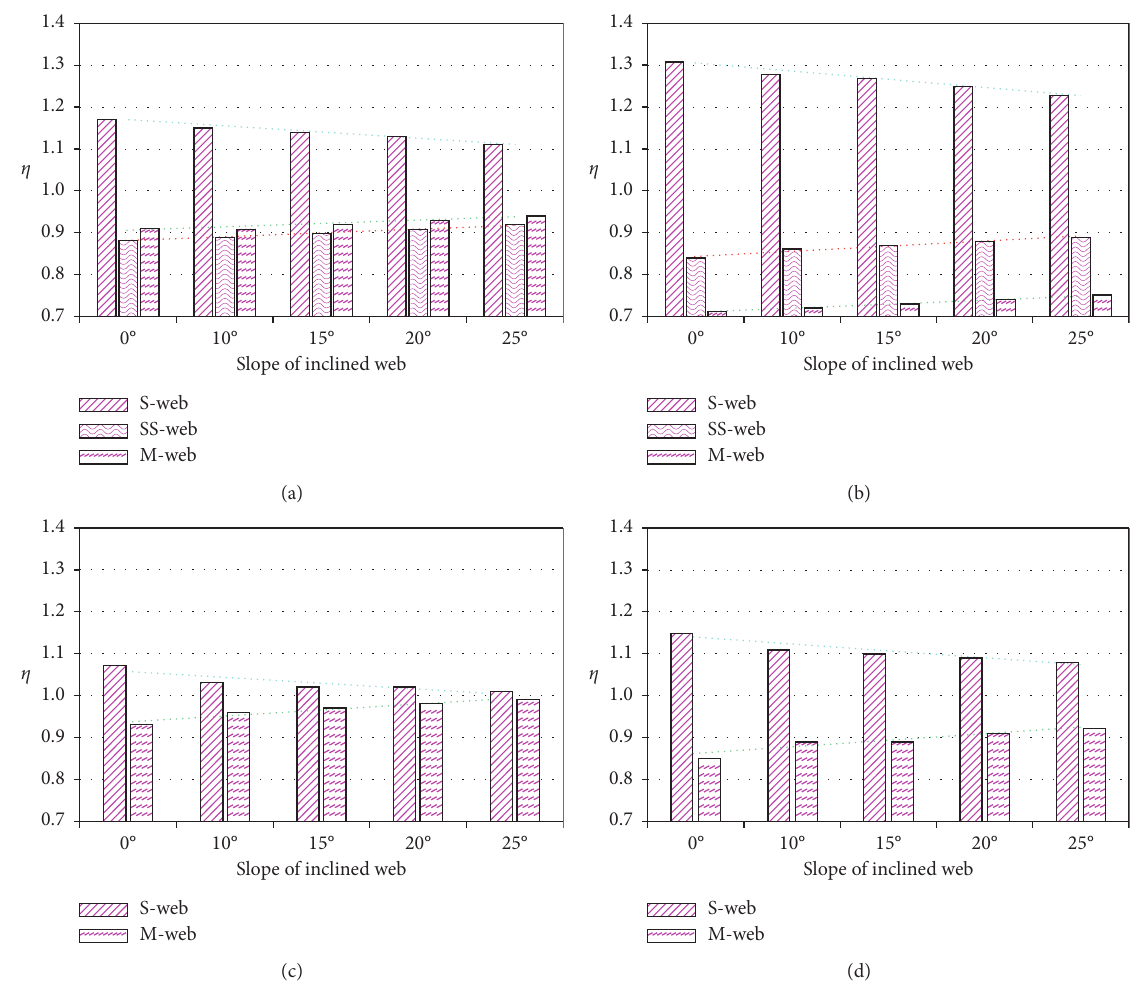
Figure 5: Effect of slope of inclined web. (a) C4S3. (b) C4S2. (c) C3S3. (d)